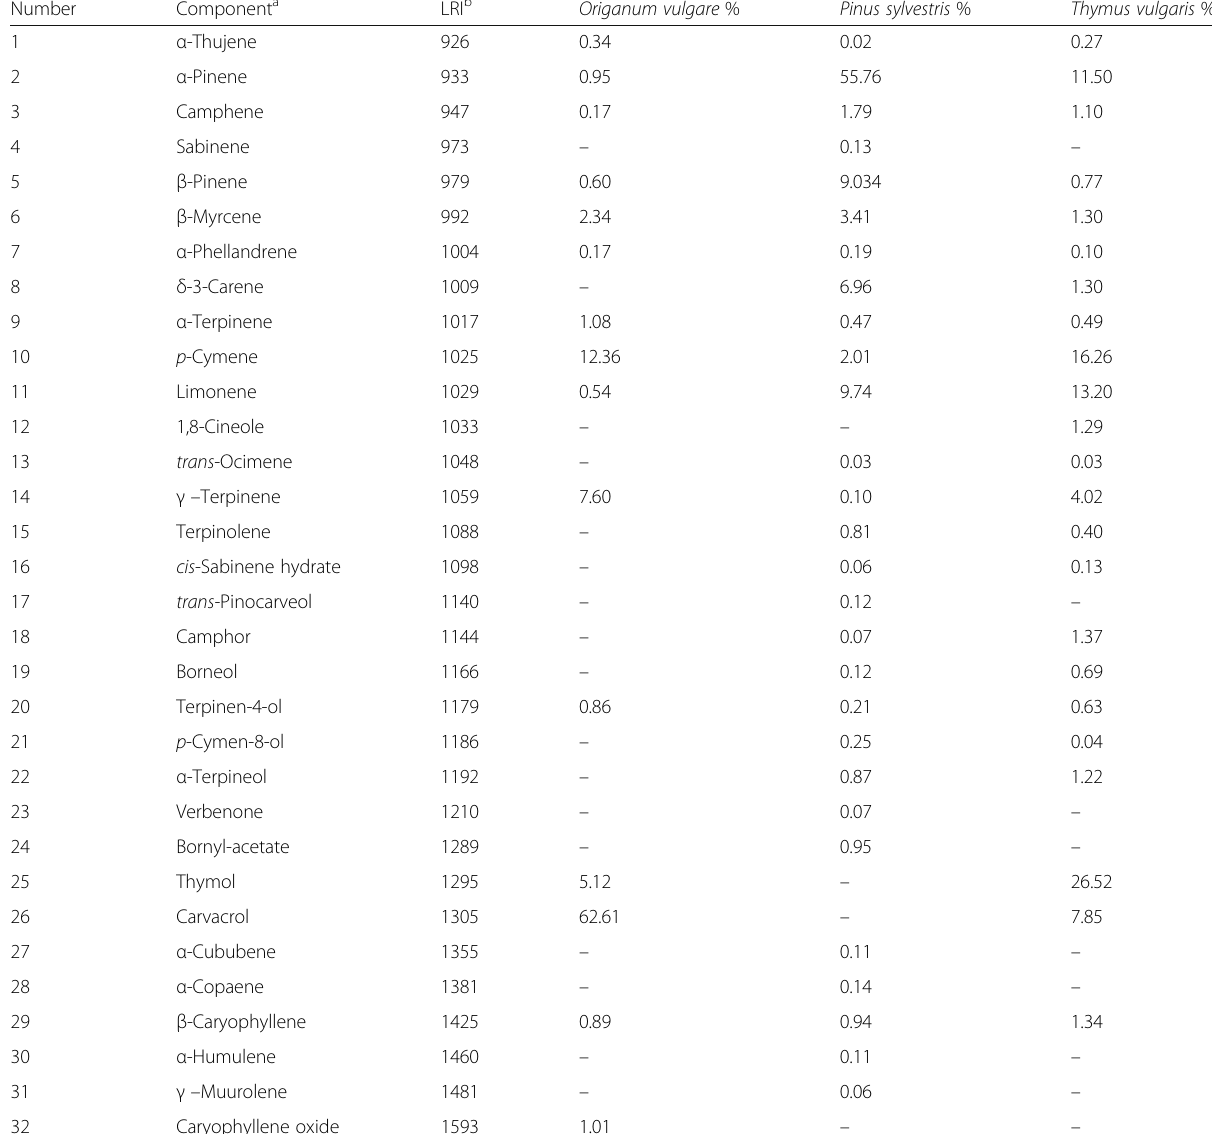
Table 1 Chemical composition of tested essential oils as determined by GC-MS